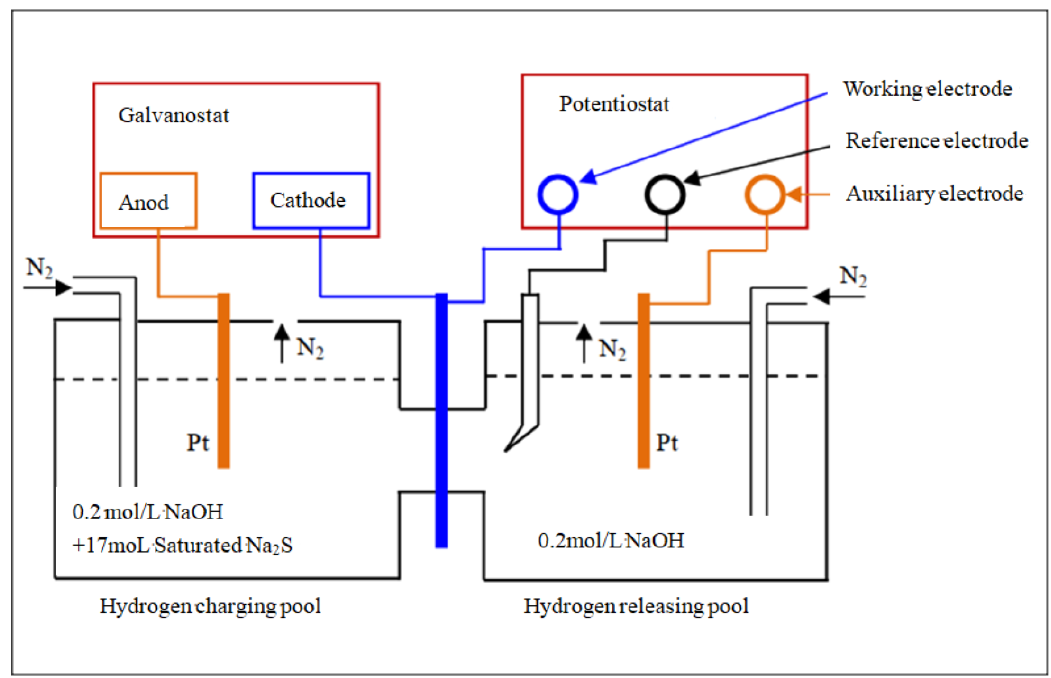
Figure 2. Schematic diagram of hydrogen permeation test device. According to the ISO 17081-2014 standard, hydrogen permeation parameters such as hydrogen permeation flux ( J ss ), effective hydrogen diffusion coefficient ( D eff ) , hydrogen concentration ( C 0 ) on the hydrogen charging side of the sample, number of hydrogen traps per unit volume ( N T ), and irreversible hydrogen traps per unit volume ( N ir ) were calculated. The calculated formulas are shown in